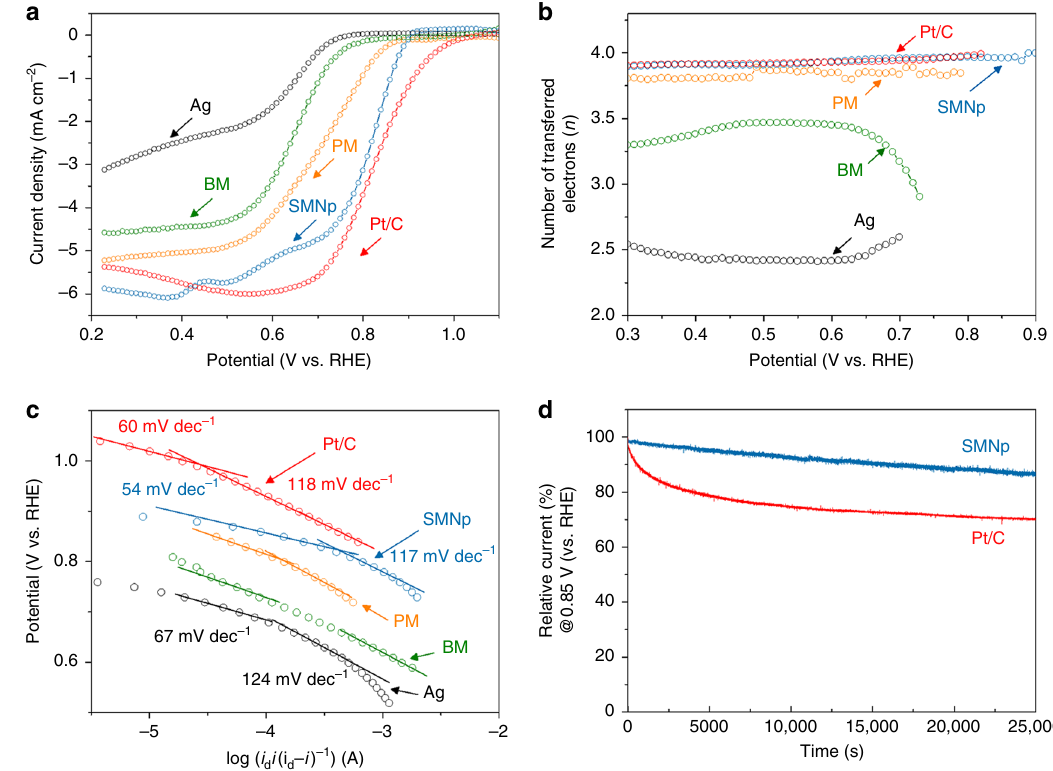
Fig. 3 Electrocatalytic activities for oxygen reduction reaction. a Linear scan voltammogram (LSV) curves for the Ag nanoparticle, bulk manganese oxides (BM), polyhedron manganese oxide (PM), silver manganate nanoplate (SMNp), and a commercial Pt/C catalyst at a rotating ring – disk electrode (1600 r.p. m) in O 2 -saturated 0.1 M KOH solution with a scan rate of 5 mV s – 1 . All data have been calibrated by using Ar-saturated 0.1 M KOH solution. b , c The corresponding number of transferred electrons ( b ) and Tafel plots ( c ) of the Ag, BM, PM, SMNp, and Pt/C. I d represents the limiting current density obtained at a potential of 0.30 V in a . d Chronoamperometric response of the SMNp and 20 wt% Pt/C in O 2 -saturated 0.1 M KOH electrolytes at 0.85 V (vs. RHE) with 1600 r.p.m showing good stability of SMNp compared with